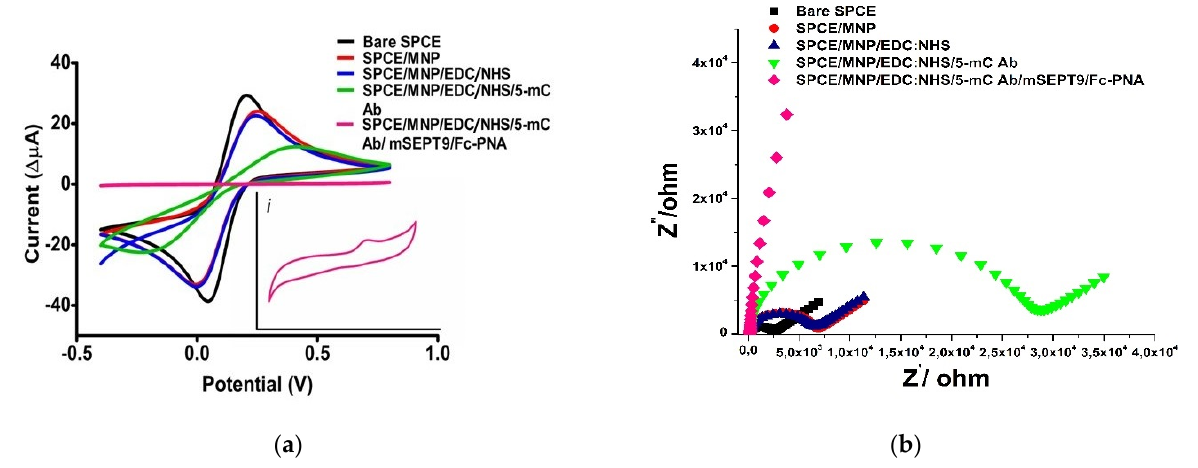
Figure 3. Surface characterisation results of the biosensor. ( a ) CV peaks between − 0.5 and 1.0 mV s − 1 scan rates (for SPCE/MNP/EDC/NHS/5-mC Ab/ mSEPT9/Fc-PNA was shown in the inset (i)]; ( b ) EIS [Electrochemical cell containing 0.1 M KCl and 5.0 mM HCF in 1X PBS buffer (pH 7.4) was used for measurements of Bare SPCE; SPCE/MNP; SPCE/MNP/EDC/NHS; SPCE/MNP/EDC/NHS/5-mC Ab steps. The electrochemical cell containing 0.1 M KCl in 1X PBS buffer (pH 7.4) was used for the measurement after addition of the mSEPT9/Fc-PNA hybridization].